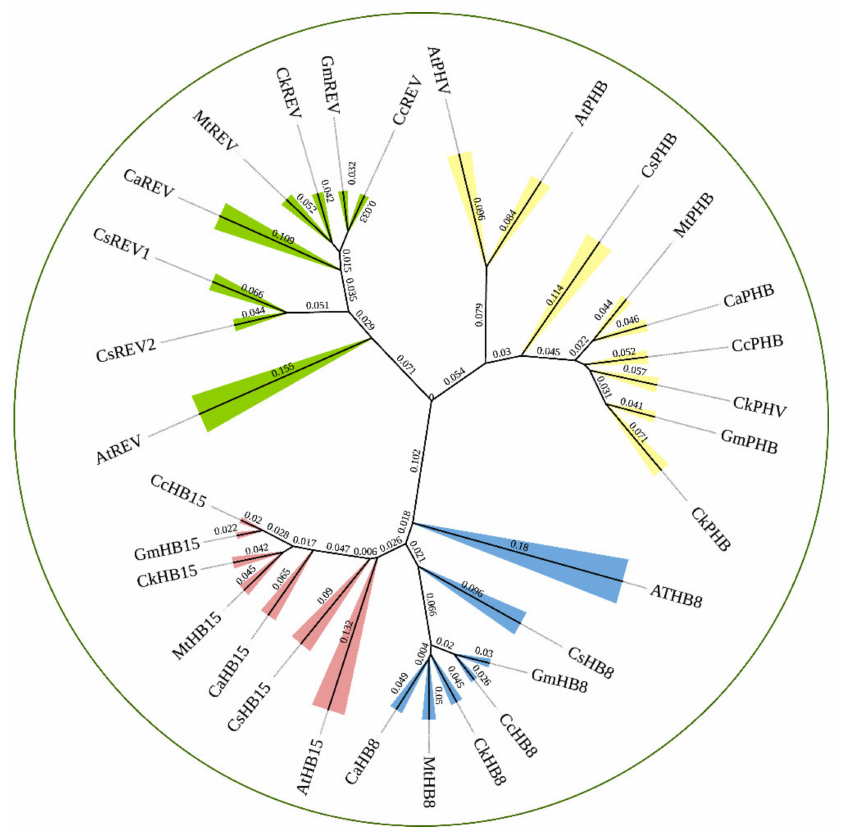
Figure 1. Phylogenetic analysis of HD-ZIP III family between C. korshinskii, G. max, C. arietinum, M. truncatula, C. cajan, C. sinensis , and A. thaliana. Bootstrap support (1000 repetitions) is shown for each